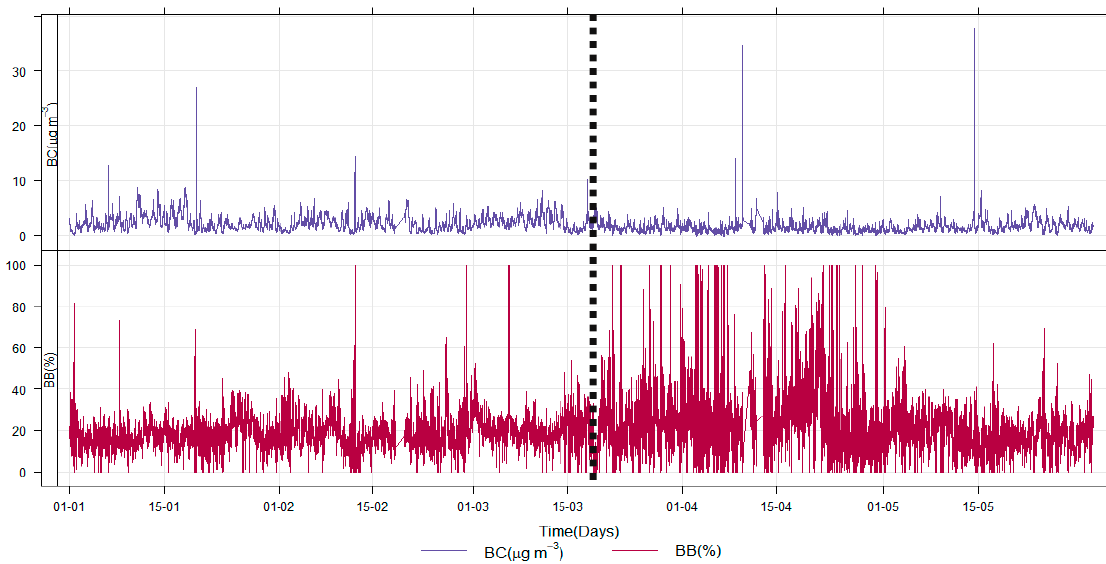
Figure 2. Time series of 1-min BC concentrations ( µ g/m 3 ) (upper panel) and BB% (lower panel) between 1 January and 31 May 2020. The MCO for COVID-19 lockdown came into force on 18 March (shown by the vertical dotted line) and remained in place for the remainder of the time series.